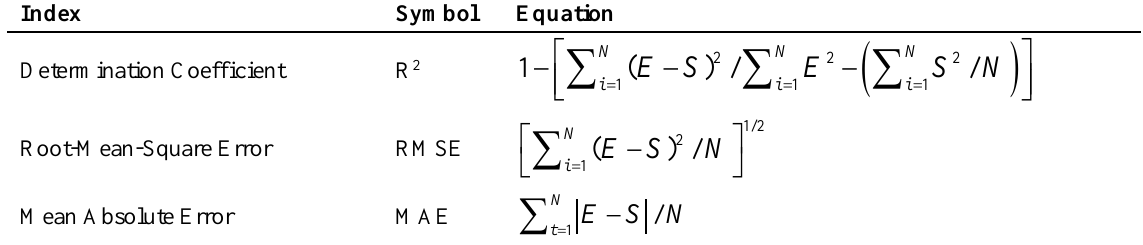
Equations of resolution assessment